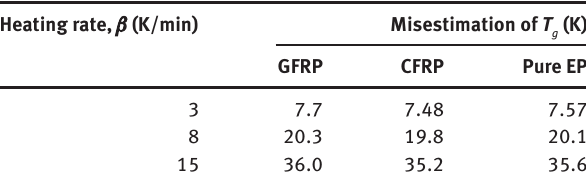
due to convection lag. g